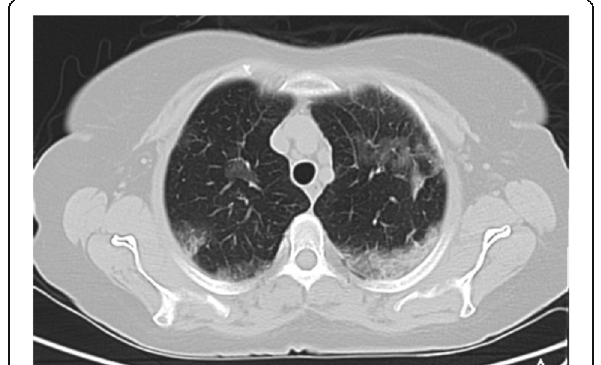
Fig. 4 Simple pulmonary eosinophilia: thin section CT shows consolidation and GGO involving mainly the peripheral regions of both upper lobes